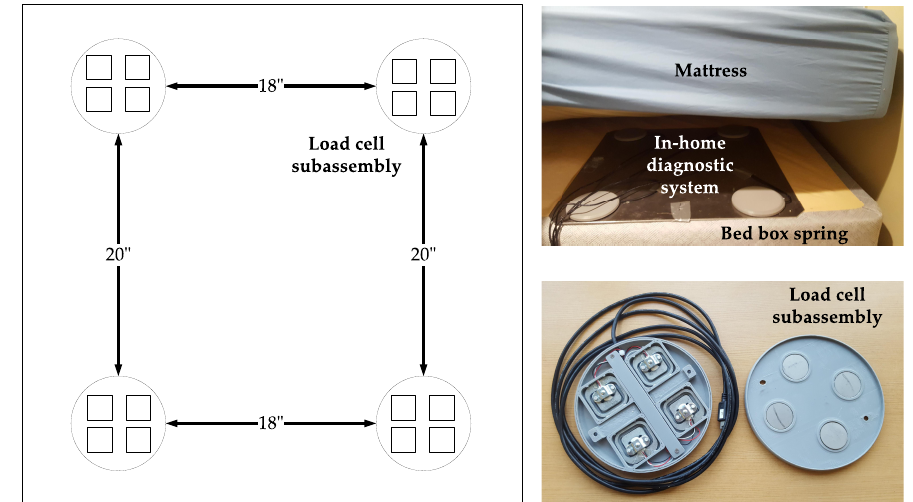
Figure 2. Oregon Health and Science University (OHSU)’s custom built data acquisition system.